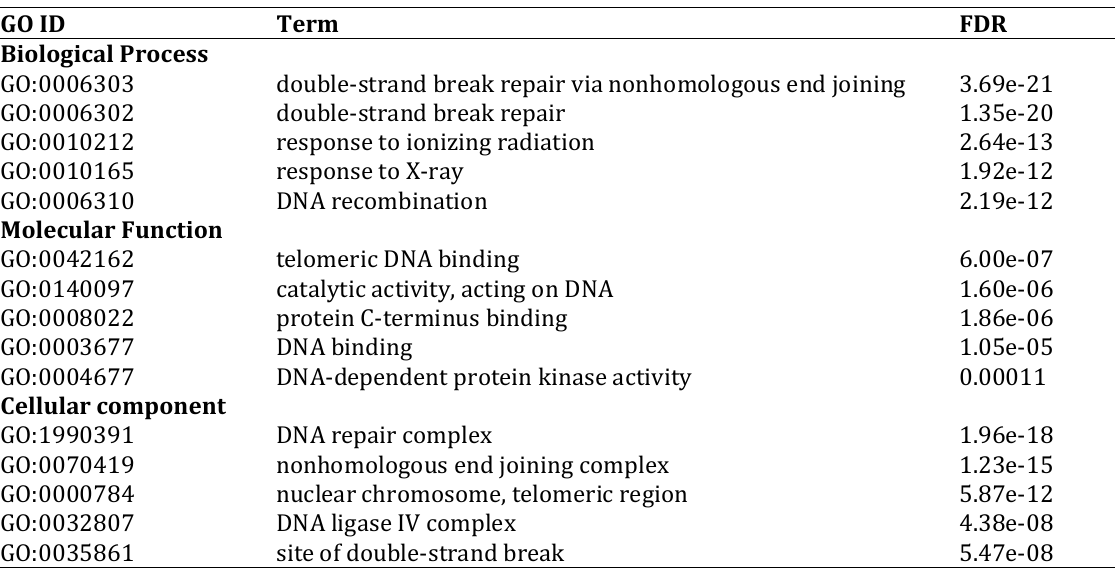
Table II. Top 5 results of GO enrichment analysis of the XRCC5 interaction network GO